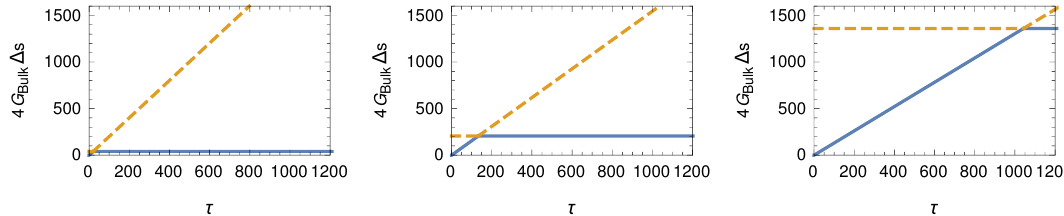
(a) The Page curve for dimensions d = 3 , 4 , 5 (left to right). The entangling surface is located at χ Σ = 1 and the DGP coupling is set to zero. The brane angle is chosen as θ B = 0 . 1 .